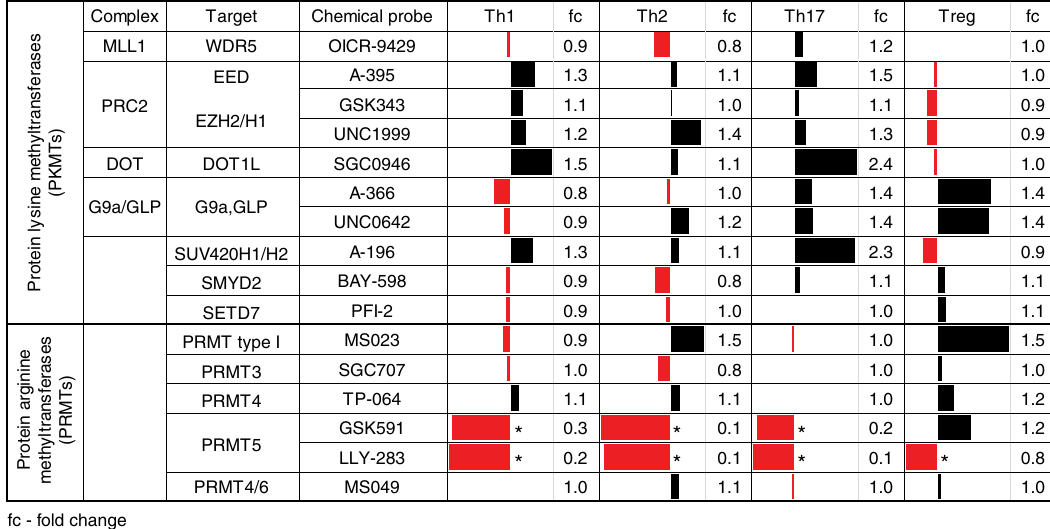
screens of the probes versus genetic ablation of individual genes in cancer, (ii) screens for optimal combinations of PMT probes with existing standard of care therapies in cellular disease models, (iii) investigation of endogenous PMT protein complexes in a variety of cells without the need to introduce tagged exogenous protein baits, and (iv) development of protein degrading reagents through derivatization of chemical probes 59 .